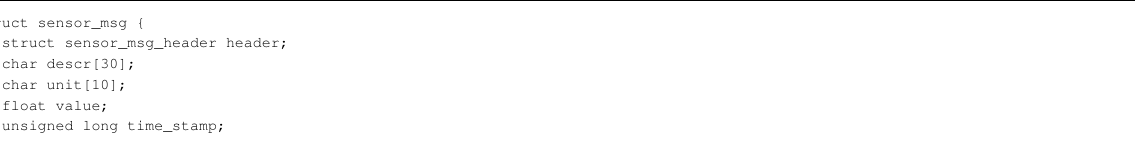
Figure 8. RAW response message. Transmission size: 52